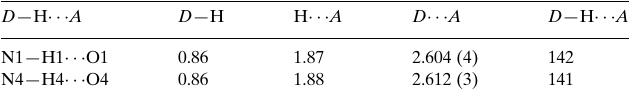
Hydrogen-bond geometry (A˚ , (cid:3)